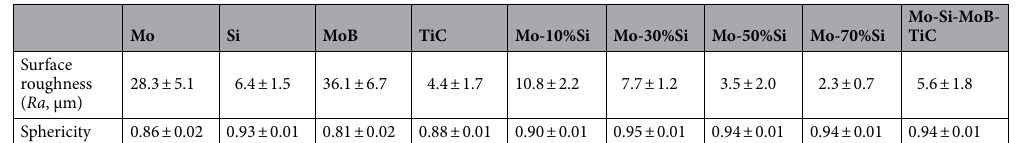
Table 2. The surface roughness (Ra) and sphericity values of different FD-POEM particles.